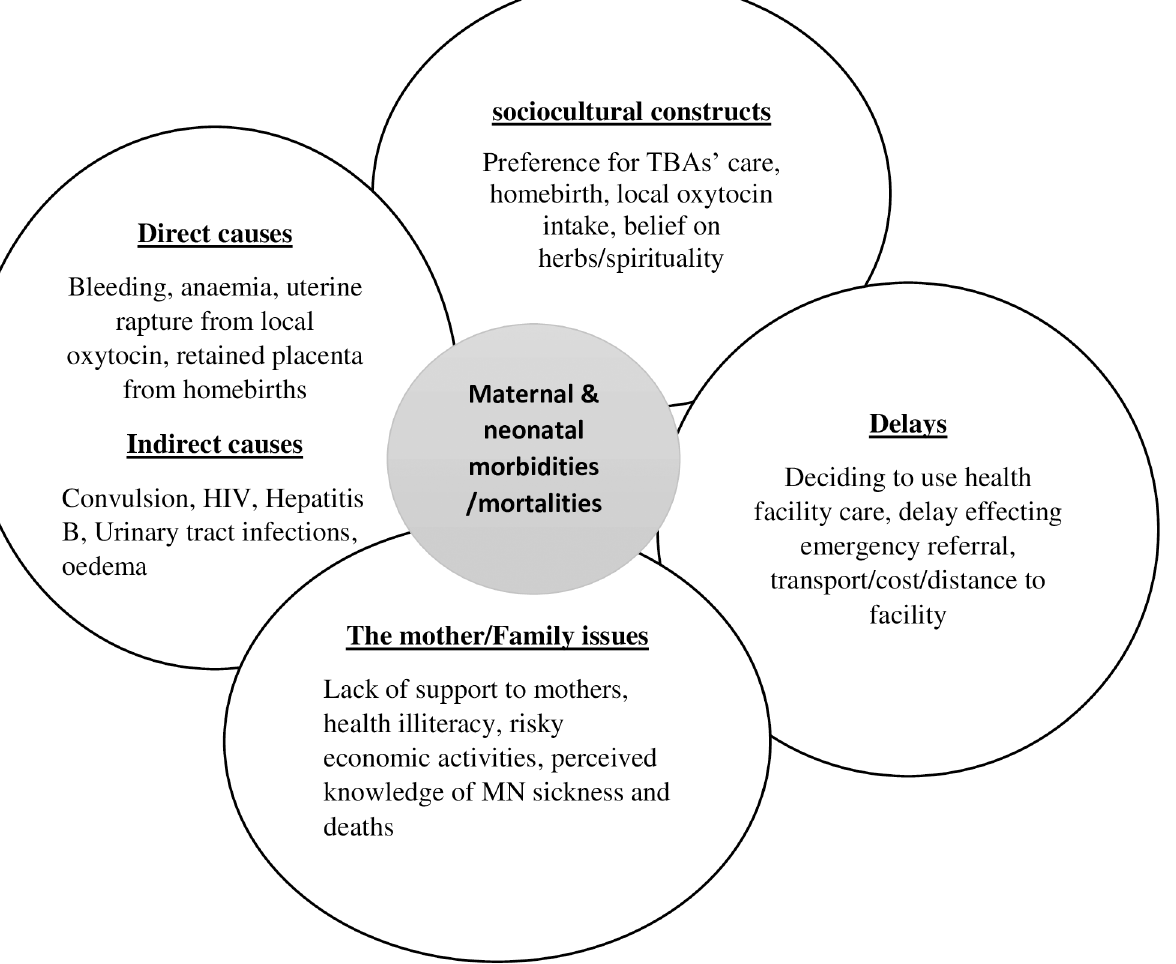
PLOS ONE | https://doi.org/10.1371/journal.pone.0183644 August 30,